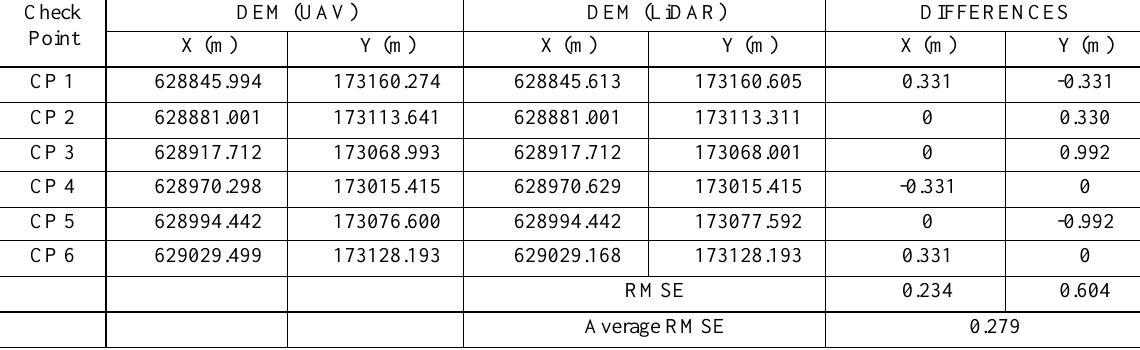
Table 6. Accuracy Assessment for UAV Derived DEM and LiDAR Derived DEM at 60m Altitude